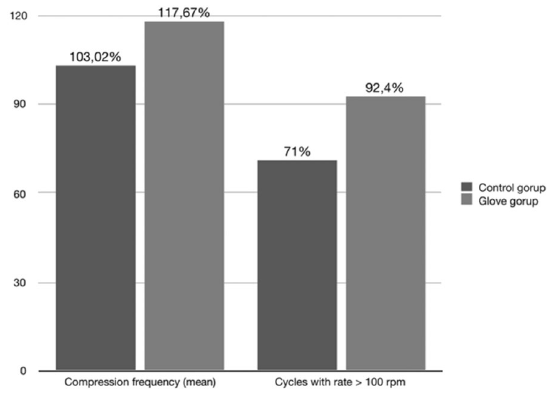
Fig. 1 Differences about compression frequency and cycles with rate greater than 100 rpm during CPR between the two groups. All values are intended as mean values